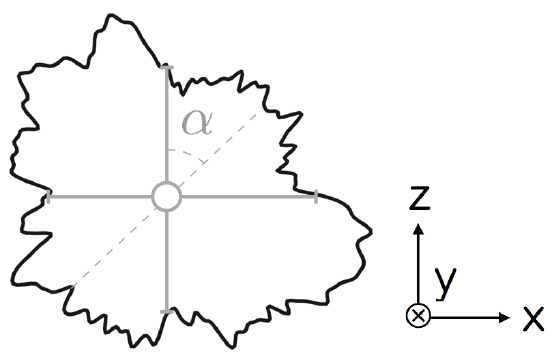
Figure 5. Schematic of the metrics used to characterize wakes: center (circle), width (horizontal gray solid line), height (vertical gray solid line) and orientation (clockwise angle from vertical α ) for a coordinate system looking downstream in y for a wake in the xz